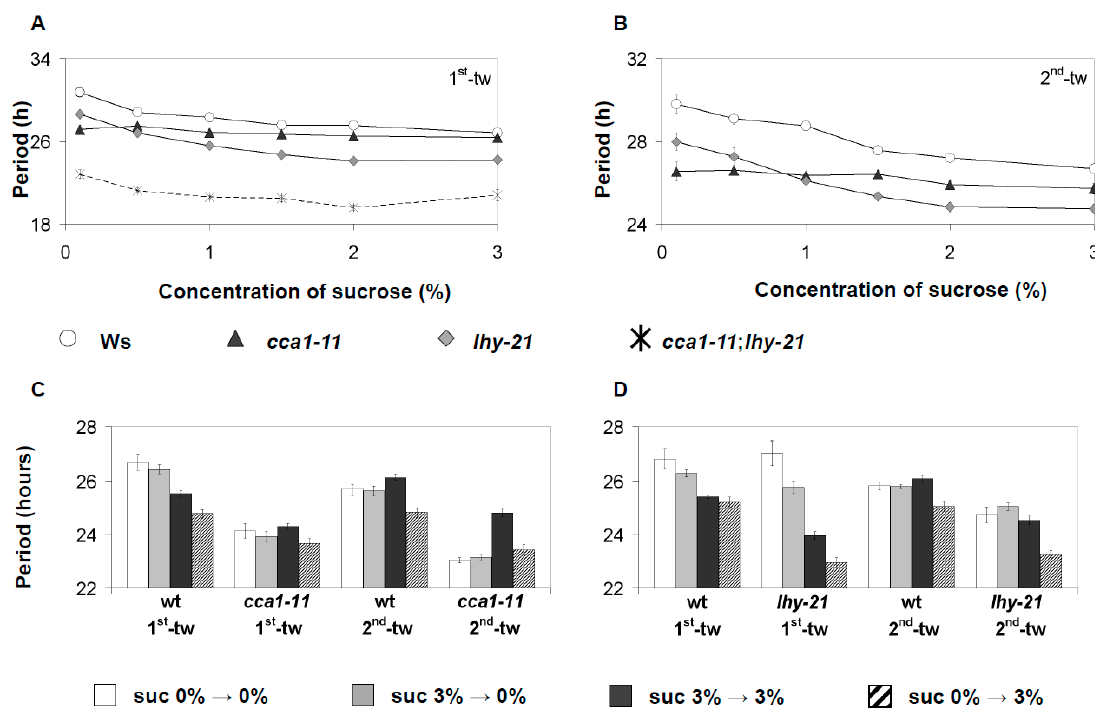
Figure 4. The effect of sucrose on oscillations of the CAB2::LUC marker in cca1-11 , lhy-21 , and cca1-11/lhy-21 . ( A , B ) The free-running period of cca1-11 , lhy-21 , or cca1-11/lhy-21 mutant harboring CAB2::LUC was examined across a sucrose gradient in two consecutive time windows under constant RL. Data were analyzed as described in Figure 1. ( C , D ) The free-running period of cca1-11 (C) or lhy-21 (D) under constant blue light was examined across two consecutive time windows. Seedlings were entrained with or no 3% w/v sucrose and then moved to media containing no or 3% w/v sucrose during free-running conditions. Data were analyzed as described in Figure 1. Error bars for (A–D) are standard error. Data represent the average of two independent experiments for both respective light conditions.